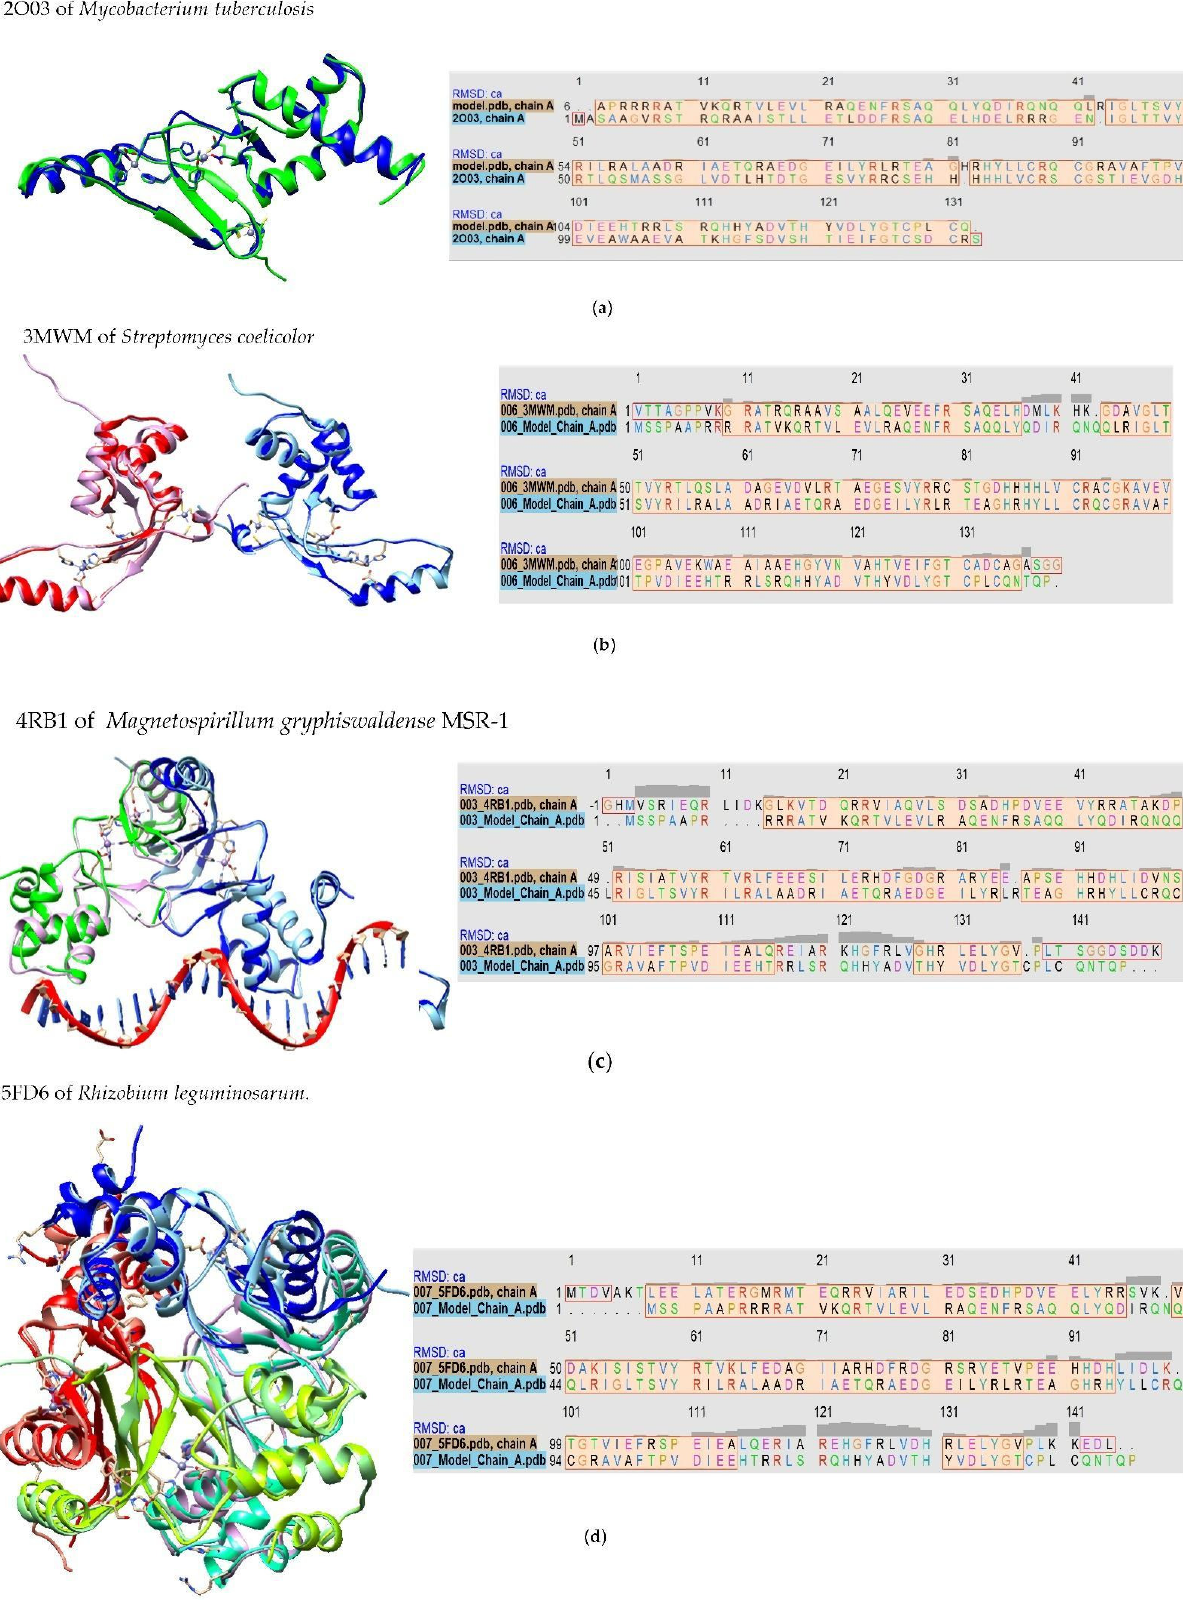
Figure 2. In silico models of the MAP3773c protein of MAP, PDB ID: 2O03 of M. tuberculosis , PDB ID: 4RB1 of M. gryphiswaldense , PDB ID: 3MWM of S. coelicolor and PDB ID: 5FD6 of R. leguminosarum . ( a ). Superposition of the blue crystals of protein PDB ID: 2O03 and the model built for MAP3773c in green. ( b ) Overlay between the model (light blue and purple) and the PDB ID: 3MWM crystal (dark blue and red), showing the alignment between Chord A of the model (bottom, in blue) and Chord A of the crystal (top, PDB ID: 3MWM). ( c ) Overlay between the model (light blue, Chain A; magenta, Chain B) and the PDB ID: 4RB1 crystal (dark blue, Chain A; green, Chain B). ( d ) Overlay between the model (pastel colors) and the crystal structure (strong colors). Alignment between Chord A of the model (bottom, in blue) and Chord A of the crystal (top, PDB ID: 5FD6). The bars labeled with the RMSD show where the greatest difference occurred between the crystal and the model, showing the greatest difference between the handles. The superposition of the MAP3773c model with the structures of proteins such as PDB IDs: 2O03, 3MWM, 4RB1, and 5FD6 suggests that MAP3773c interacts with a struc- tural zinc atom in the cysteines (91, 94, 131, and 134). If we consider the intermolecular distances of the different superpositions, the structure that showed the lowest atomic dis- tance was from PDB ID: 2O03, with the exception of cysteine 94, which presented an in- termolecular distance of 2.18 Å, with the other crystals (PDB IDs: 3MWM, 4RB1, and 5FD6) having an intermolecular distance of 1.77 Å. We suggest that MAP3773c possibly has another Zn 2+ atom at the histidine (85, 87, and 123) and glutamic acid (107) positions, according to the data from the overlays with the PDB ID: 2O03 crystal, which is linked to the amino acids histidine (87,89 and 125) and glutamic acid (108). In the case of the PDB ID: 3MWM crystal, it has a zinc atom at the histidine positions (84, 86, and 122) and glu- tamic acid (105). On the other hand, the PDB ID: 5FD6 crystal has histidine (36, 91, and 93) and glutamic acid 84. However, it is also possible that MAP3773c forms a bond with Mn 2+ at the histidine positions (85, 87, and 123) and glutamic acid (107), according to the super- position with the PDB ID: 4RB1 crystal, which forms the bond with the Mn 2+ with histidine (87 and 125), aspartic acid (89), glutamic acid (108), and water at position 301. The aspartic acid at position 89 of the PDB ID: 4RB1 crystal is not present in MAP3773c; instead, it has one at position 72 and a glutamic acid at position 82, which probably has an interaction with the Mn 2+ . The intermolecular distances derived from the superposition of the crystals of PDB ID: 2O03, were 1.0, 2.43, and 2.34 Å of histidine (87, 89, and 125) and 3.11 Å of glutamic acid (108). In the case of the PDB ID: 3MWM overlay, the histidine (84, 86, and 122) was at 1.96, 2.05, and 2.04 Å, respectively, and the glutamic acid (105) was at 1.64 Å. In PDB ID: 4RB1, histidine (87 and 125) was at 2.31 and 2.07 Å, respectively, aspartic acid (89) was at 2.05 Å, glutamic acid (108) was at 2.41 Å, and water (301) was at 2.36 Å. In the